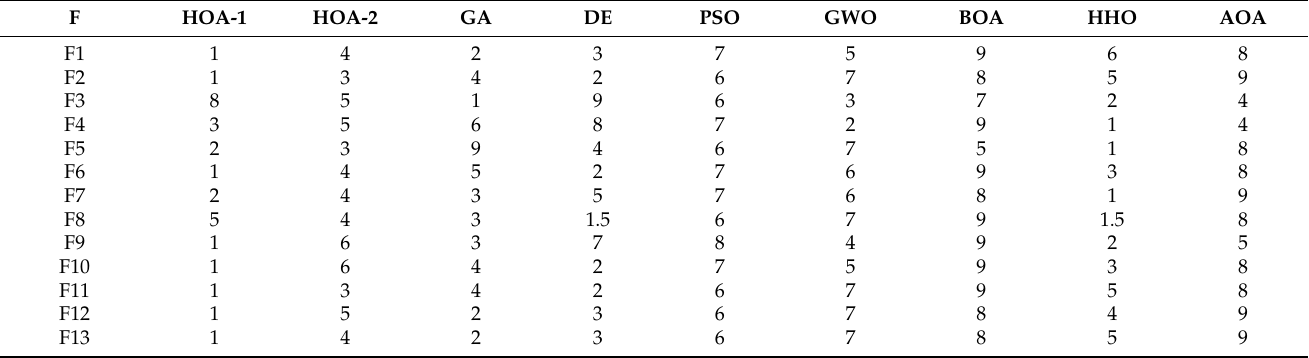
Table 5. Ranking-based Friedman test for the comparative